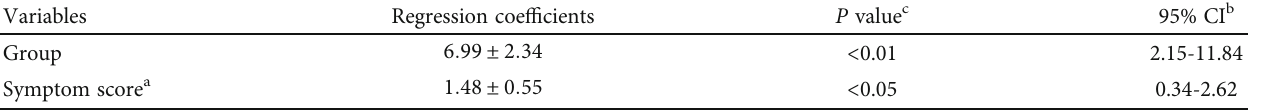
Table 5: Regression analysis between the di ff erent variables in peptic ulcer